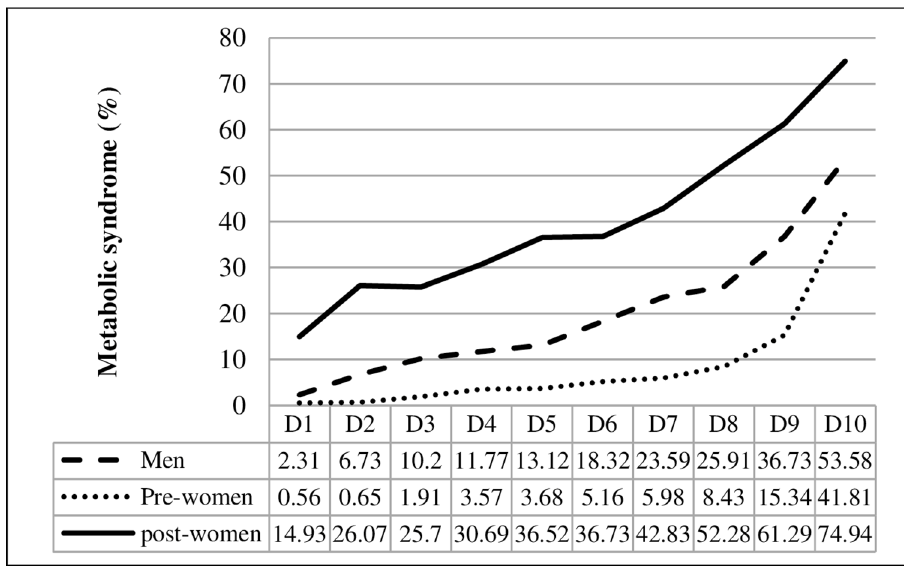
Fig 1. Prevalence of metabolic syndrome according to HOMA-IR. HOMA-IR: homeostasis model assessment of insulin resistance; Pre-women: premenopausal women; Post-women: postmenopausal